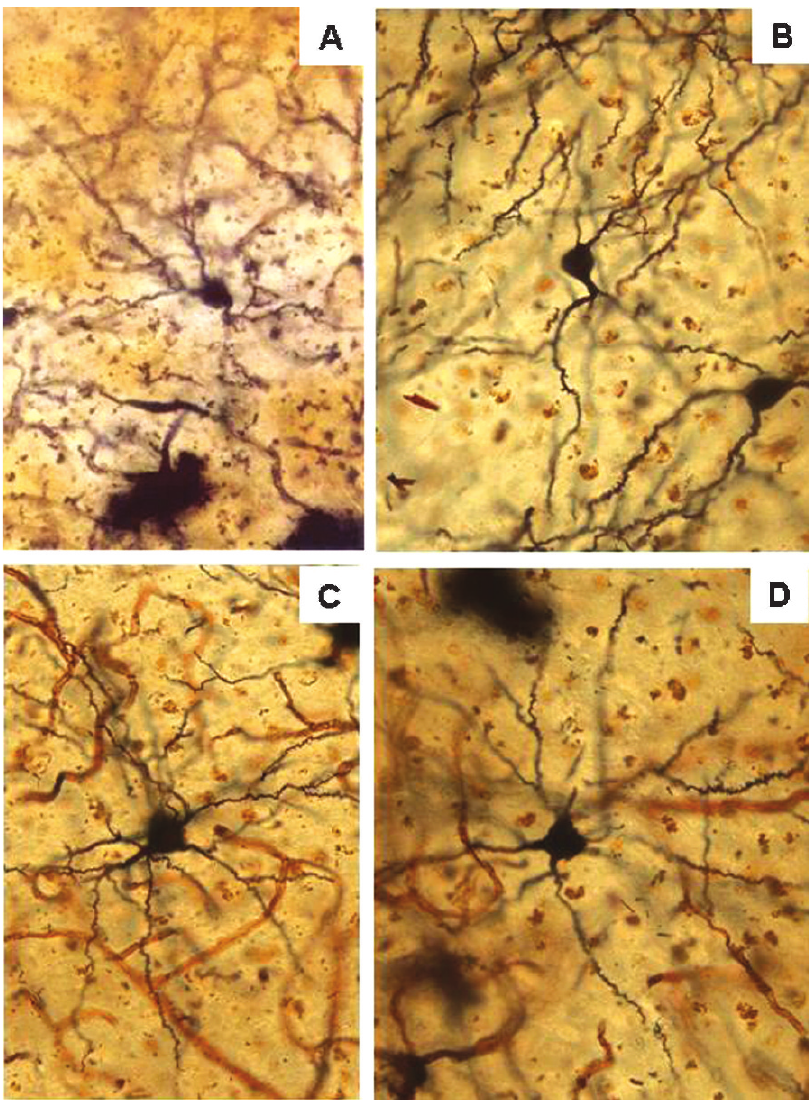
Figure 2 - Photomicrographs of silver-nitrate-impregnated basolateral amygdaloid neurons from control rats A) and rats treated with Bacopa monniera , BM, for 4 weeks at doses of 20 mg/kg B), 40 mg/kg C) and 80 mg/kg D). A significant increase in dendritic arborization in the BM 40 and 80 mg/kg groups